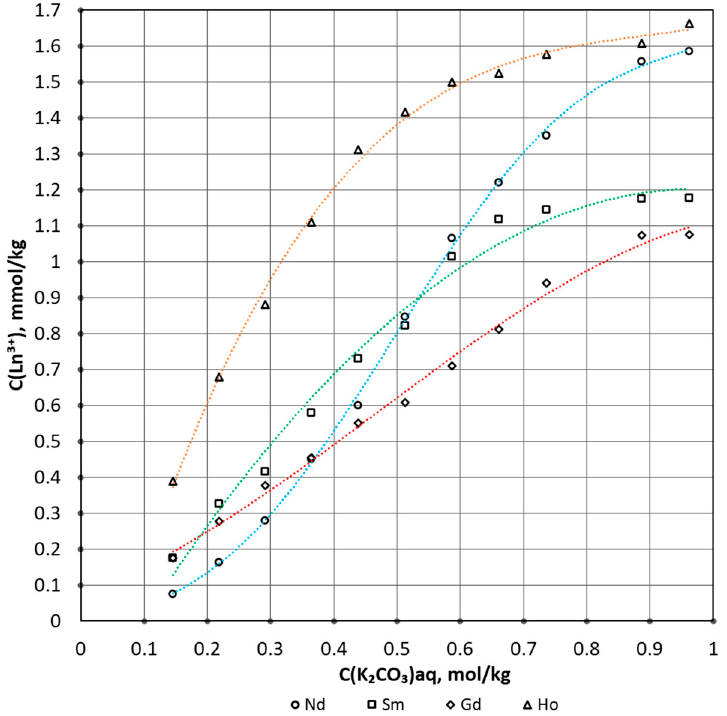
Figure 1. Solubility isotherms: blue line for neodymium, green line for samarium, red line for gadolinium, orange line for holmium.